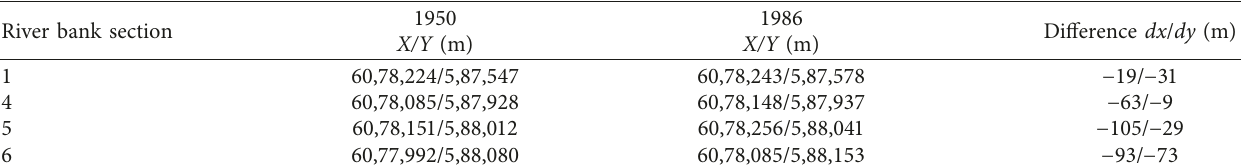
Table 2: Changes in the section of the river channel.